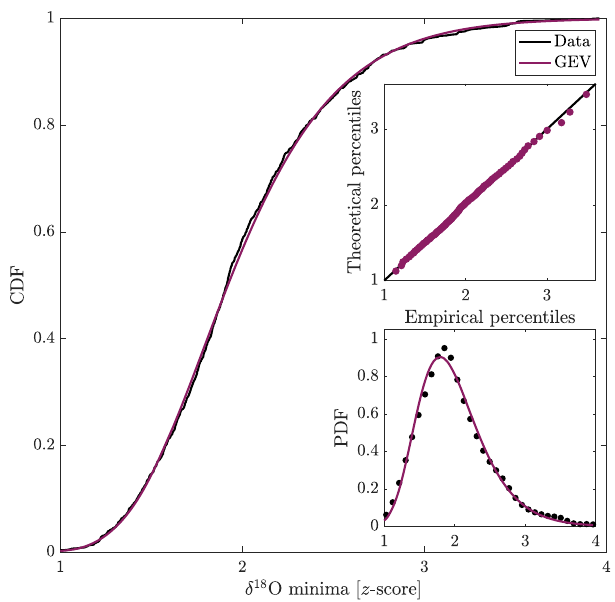
Fig. 2 Cumulative distribution functions for standardized δ 18 O block minima and generalized extreme value distribution with maximum- likelihood-estimated parameters. Lower inset: corresponding probability density functions. Upper inset: corresponding percentiles of each distribution.